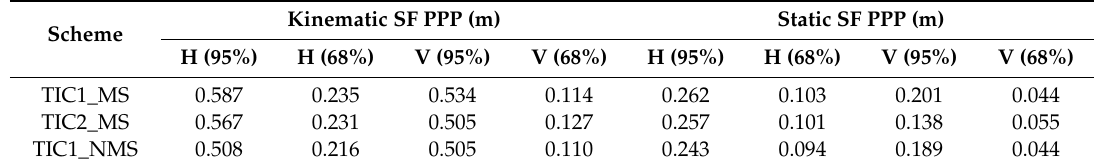
Table 5. The RMS of GPS static and kinematic SF PPP in MS and NMS of TIC1 or TIC2.